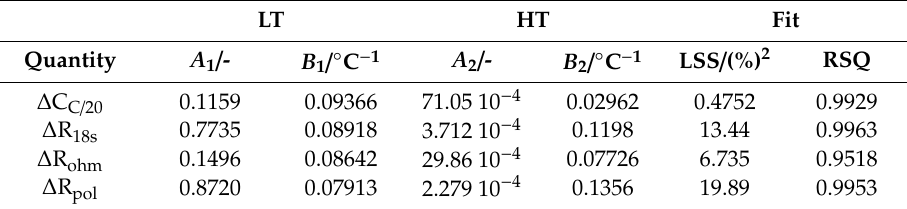
Table 3. Exponential fit coe ffi